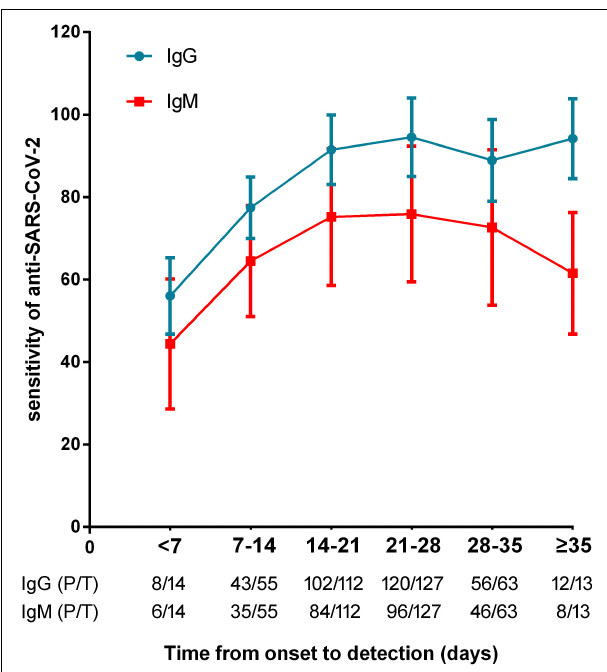
FIGURE 4 | The sensitivities of anti-SARS-CoV-2 antibodies in patients with different timepoints (calculated from onset of symptoms to antibody detection). P/T, positive number/total number.